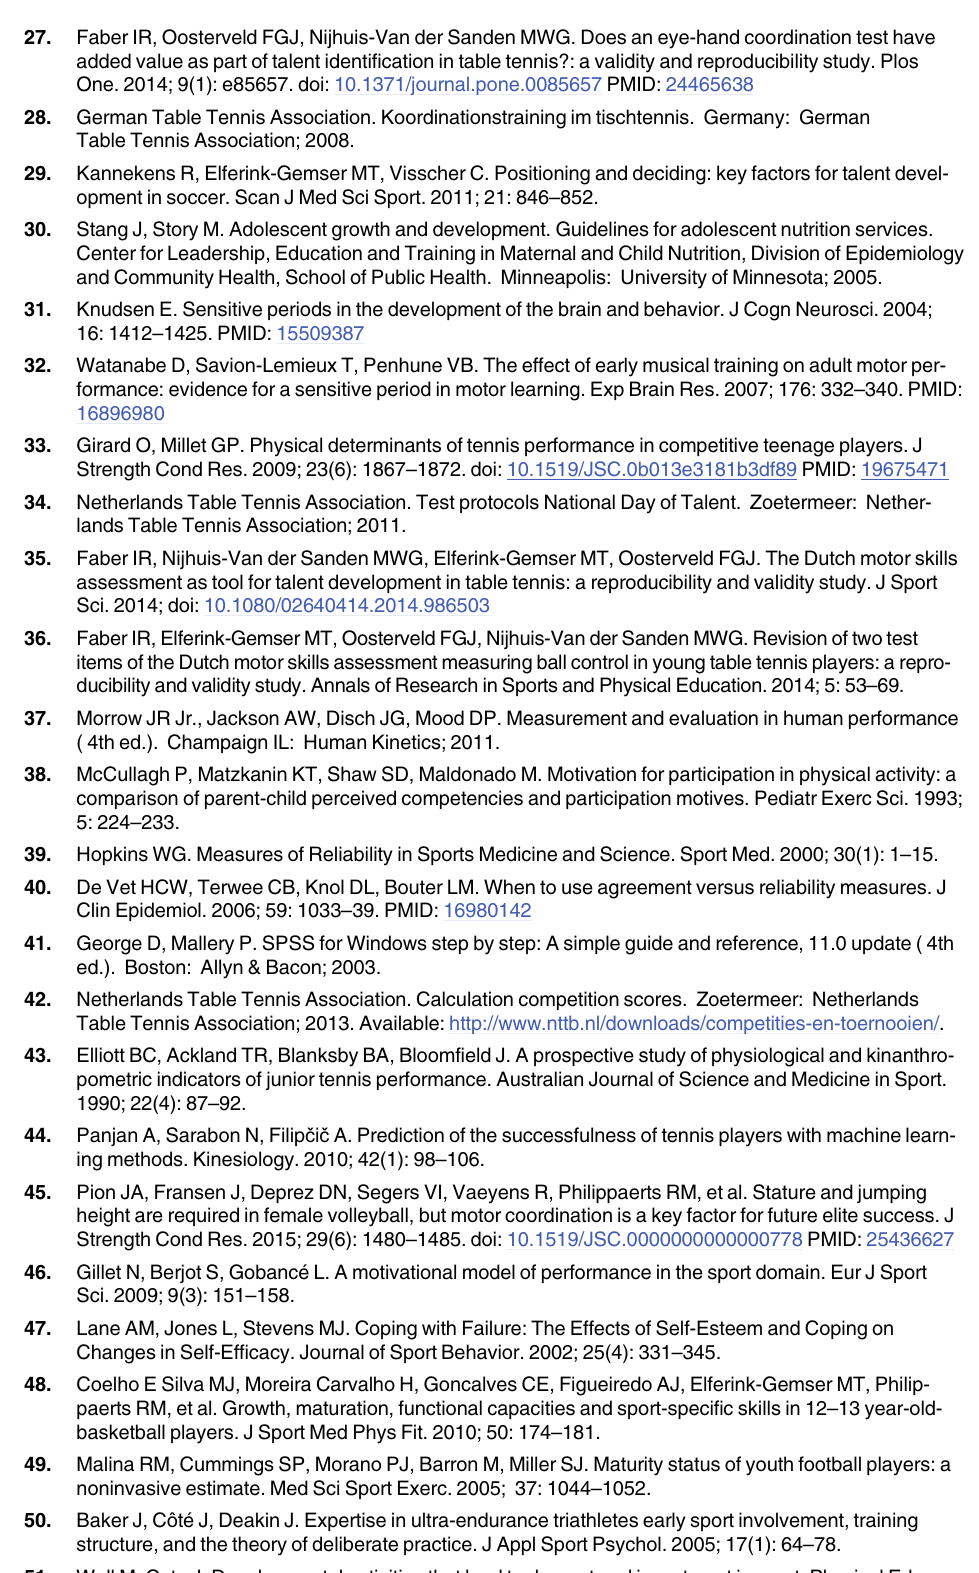
28. German Table Tennis Association. Koordinationstraining im tischtennis. Germany: German Table Tennis Association; 2008.